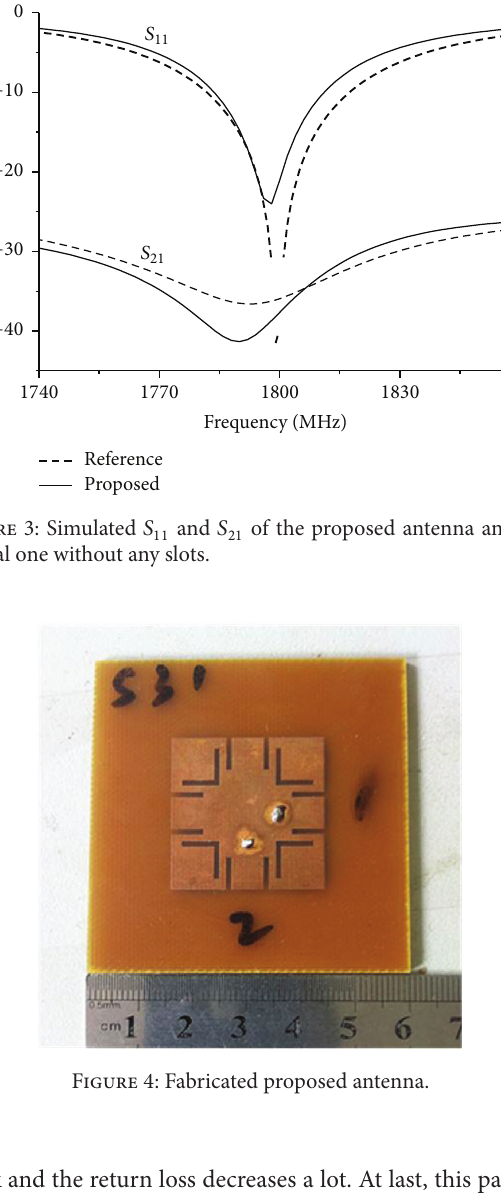
Figure 6: Simulated and measured 𝑆 11 and 𝑆 21 of the